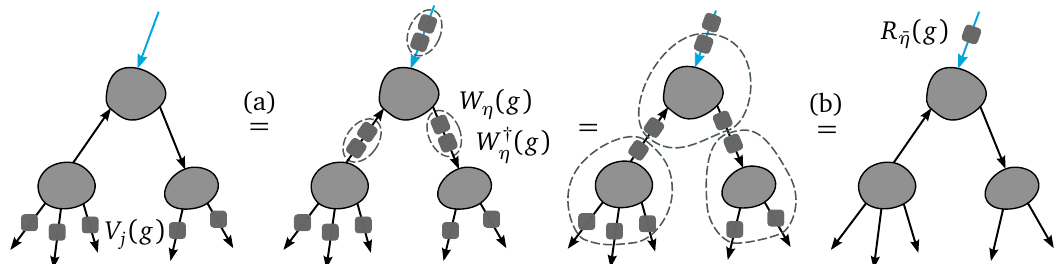
Figure 16: Symmetric tensor network, composed of symmetric tensors. A global pointwise operation on the physical links (left) is absorbed by the network as